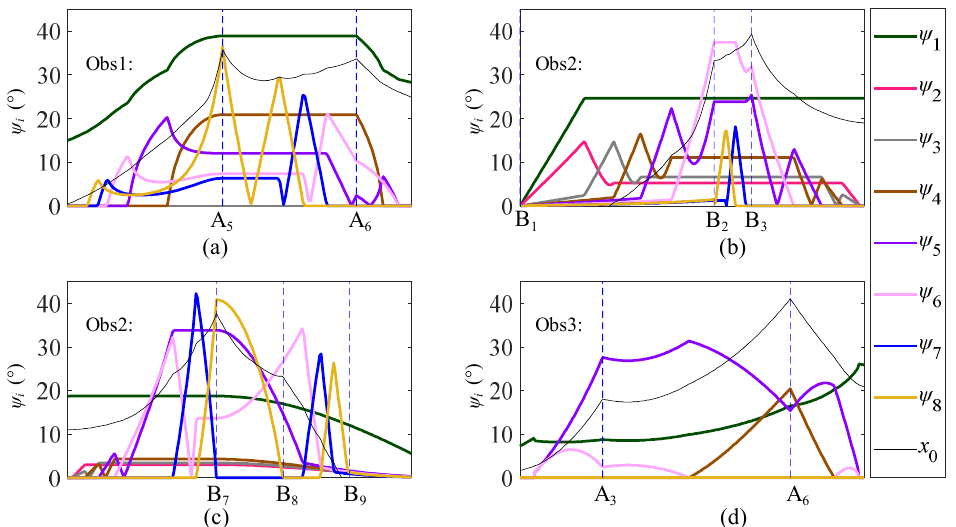
Figure 15. Local variation in the link angle at four positions. ( a ) The first partial enlargement of link angle; ( b ) The second partial enlargement of link angle; ( c ) The third partial enlargement of link angle; ( d ) The fourth partial enlargement of link